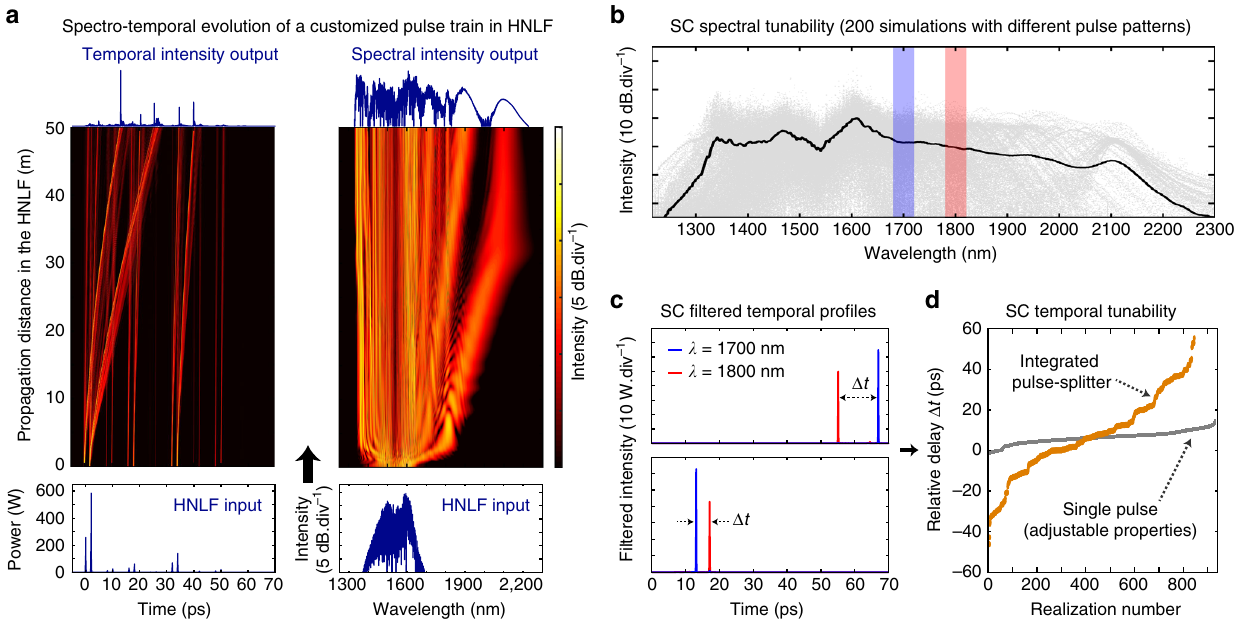
Fig. 5 Numerical simulations showing control of the supercontinuum spectral and temporal properties. a Example of supercontinuum (SC) temporal (left) and spectral (right) evolution in 50 m of highly-nonlinear fi bre (HNLF). A train of 64 pulses, prepared using the integrated pulse-splitter (bottom), is injected into the HNLF to generate a broadband supercontinuum (top). b SC spectra obtained by simulating the propagation of 200 randomly prepared pulse patterns (grey). The average spectrum of these is plotted in black. Additional numerical analysis shows that despite different evolution dynamics, the respective spectra individually retain a high average degree of coherence < g > thanks to the (coherent) optical splitting method employed (The average coherence of each individual spectrum illustrated, computed over a 20 dB bandwidth, was < g > = 0.973 — see Methods) 3,7,39 . c Examples of two different SC temporal pro fi les (top and bottom panel — obtained from two different input pulse patterns) after narrowband fi ltering at two speci fi c wavelengths (i.e. 1700 and 1800 nm — see blue and red shadings in ( b ), respectively), showing that the differently-coloured pulses can exhibit diverse arrival times. d The relative delay between these fi ltered output pulses is computed for various integrated pulse-splitter con fi gurations (brown dots). We found an enhanced temporal tunability compared to SC generated from a single input pulse with randomly adjusted properties (grey squares) — see